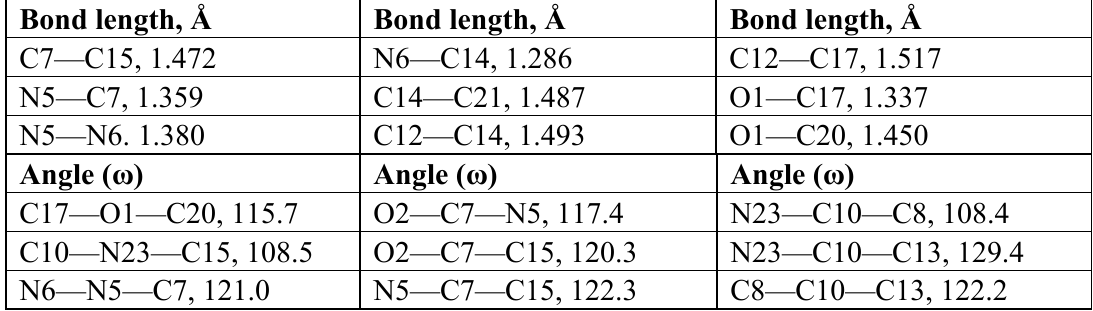
Table 1. Selected bond lengths and bond angles in the ORTEP representation of compound 3 in the crystal. The crystallographic numbering does not reflect systematic